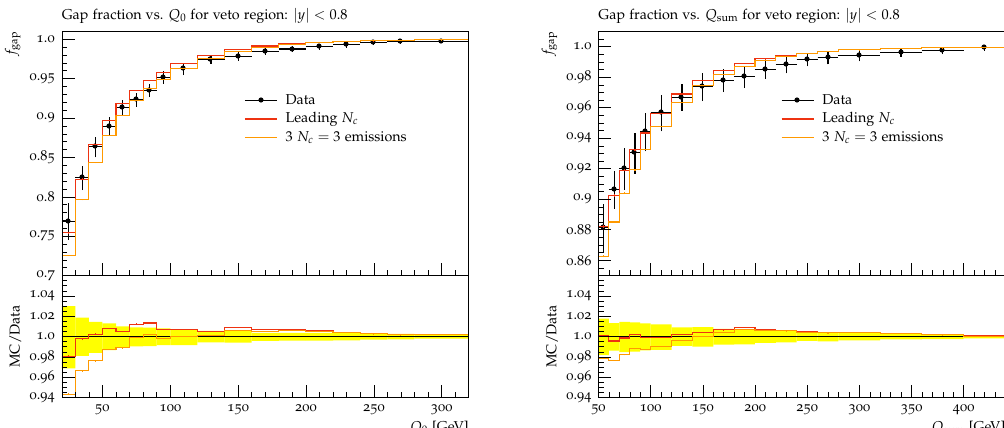
Figure 9 . The angle (cid:12) , de(cid:12)ned as in eq. (7.4) using (left) an underlying 2 (right) an underlying 2 3 hard process. Data and Rivet analysis are taken from [67]. !